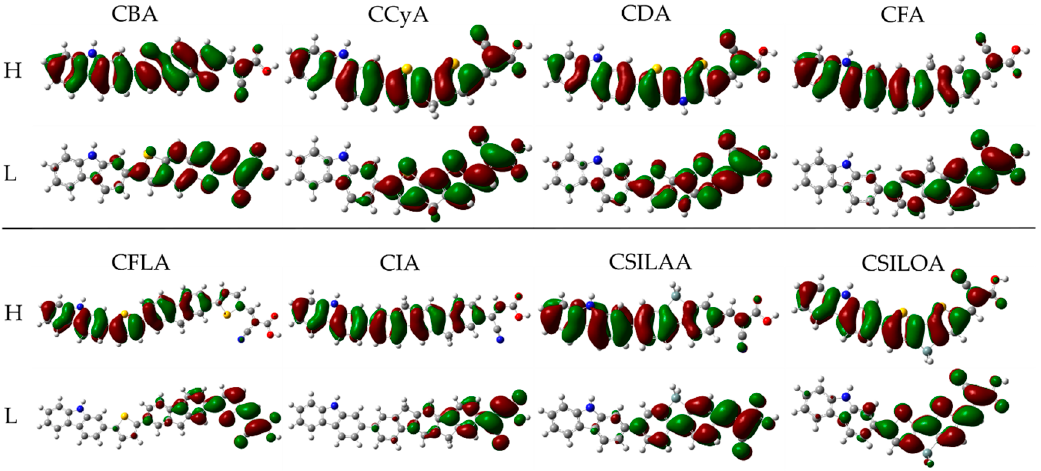
Figure 3. Density of HOMO and LUMO frontier molecular orbitals of the carbazole-based dyes at M06/6-31G(d) level of theory.